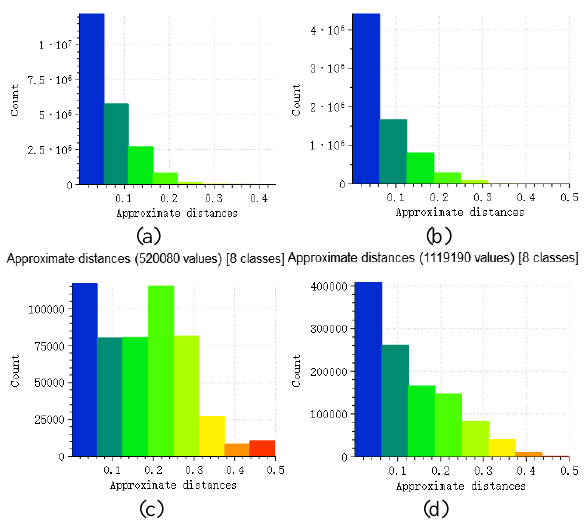
Figure 13. Analysis of point cloud registration